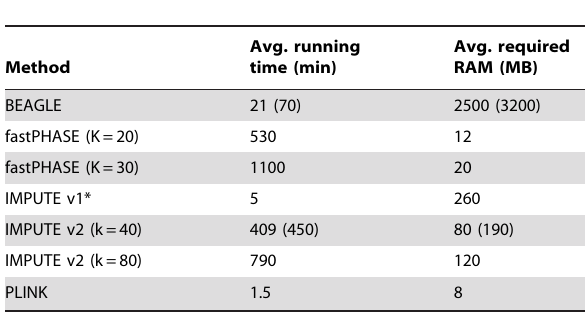
Table 3. Running times and memory requirements for various algorithms in Scenario